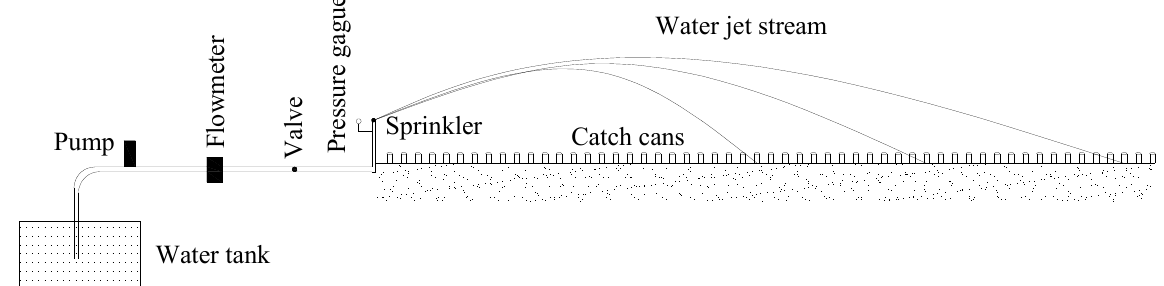
Figure 3. Schematic diagram of the experimental system in the laboratory.